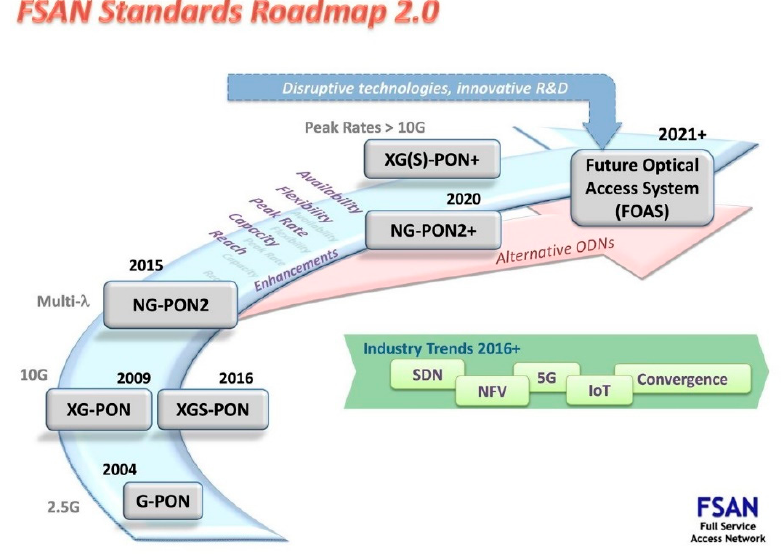
Figure 1. FSAN standard roadmap released in 2016.